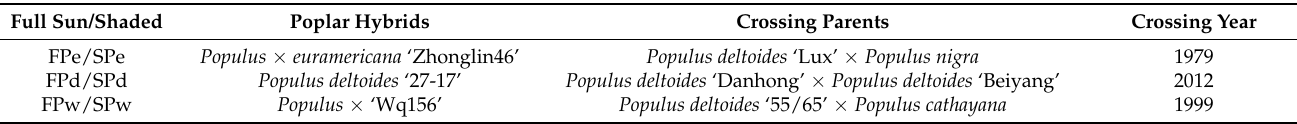
Table 1. Background of three poplar